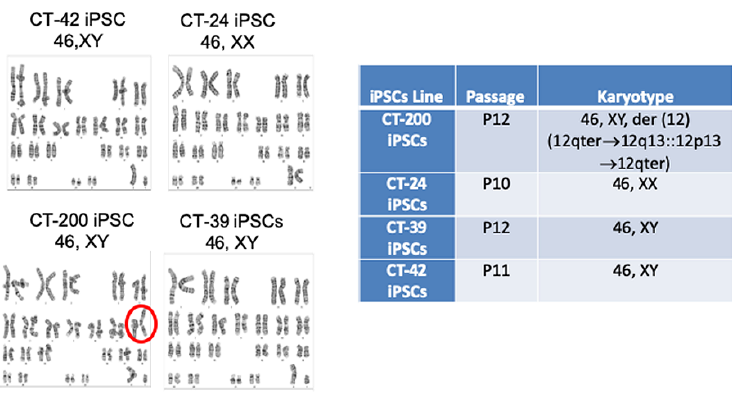
Figure 5. Karyotype analysis of iPSC derived from CT-MSC. Karyotype detected by G-band analysis of representative iPSC lines demonstrates that CT-42 iPSCs and CT-39 iPSCs carry a normal diploid male karyotype and CT-24 iPSCs carries a normal diploid female karyotype. CT-200 iPSCs carries a mostly normal diploid female karyotype with an abnormal chromosome 12 (red circle).